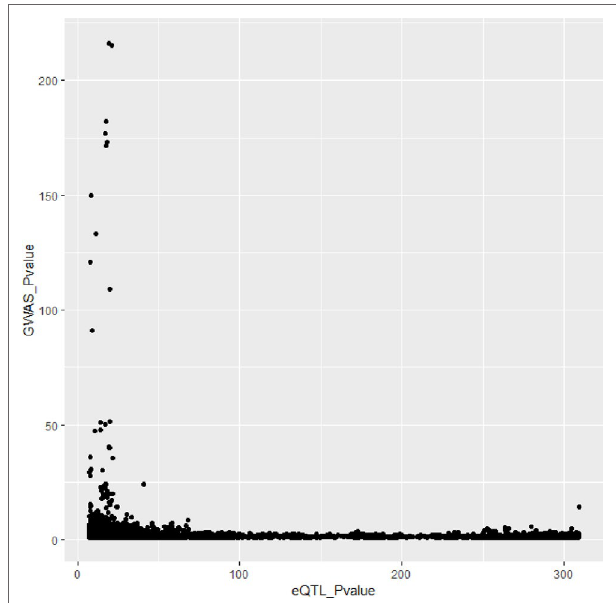
FIGURE 3 | Duplicated SNPs’ P value in genome-wide association study ( GWAS) and eQTL.